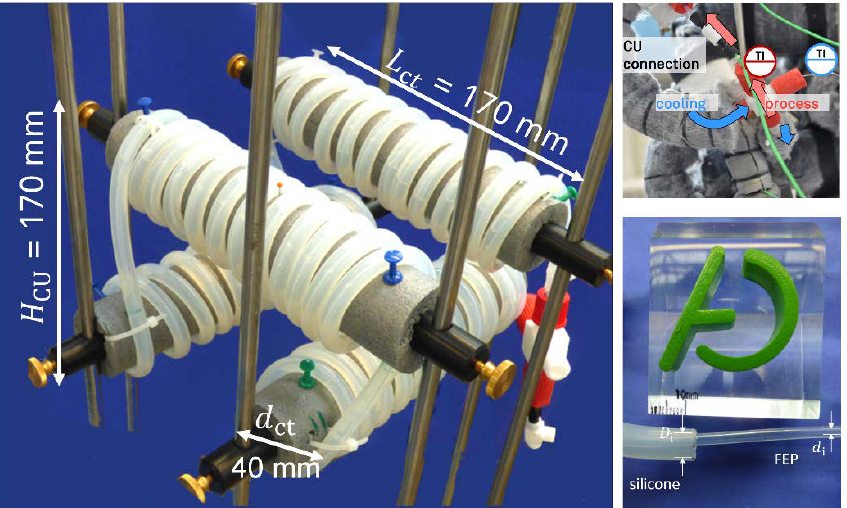
Figure 1. Left, separate CU without insulation; upper right, CU connection with temperature sensors; and bottom right, FEP-in-silicone tube construction.